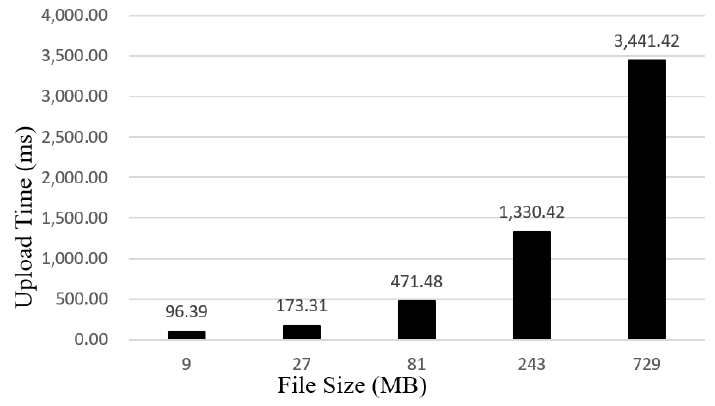
Figure 9. The relation between file size and upload time.